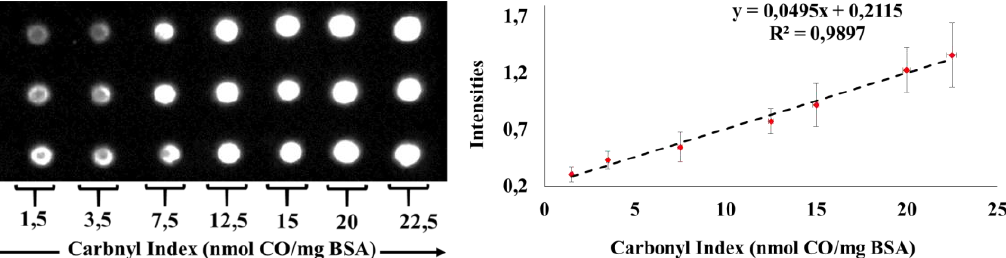
Figure 2. Curve of BSA for determination of carbonyl indexes employed Dot Blot assay. 200 ng of derivatized Bovine Serum Albumin (BSA) marked with 2,4-Dinitrophenylhydrazine (DNPH) were spotted by triplicate using Polyvinylidene fluoride (PVDF) membranes. Two curves were analyzed on two different days. The curves show linearity in the interval of the carbonyl index between 1.5 and 22.5 nmol of carbonyl / mg protein (R 2 > 0.99).